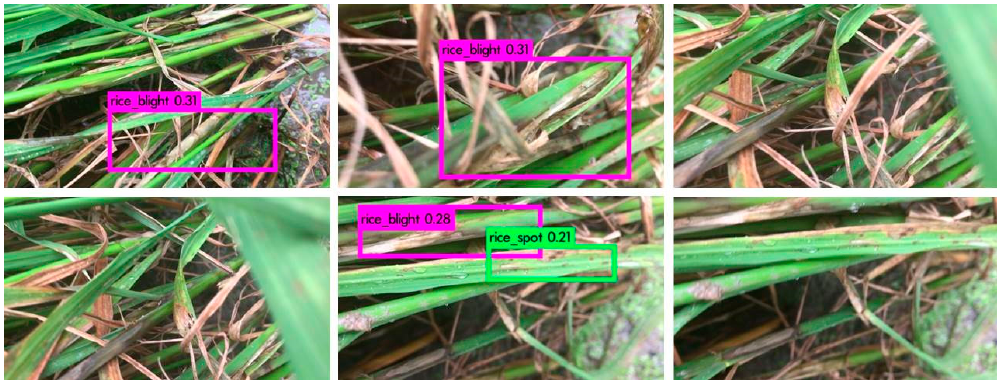
Figure 10. Detection results of YOLOv3 using Video 1. The red box denotes rice sheath blight, green box denotes rice brown spot. Video 1 was captured in Hunan Province, China, July 2018, which was